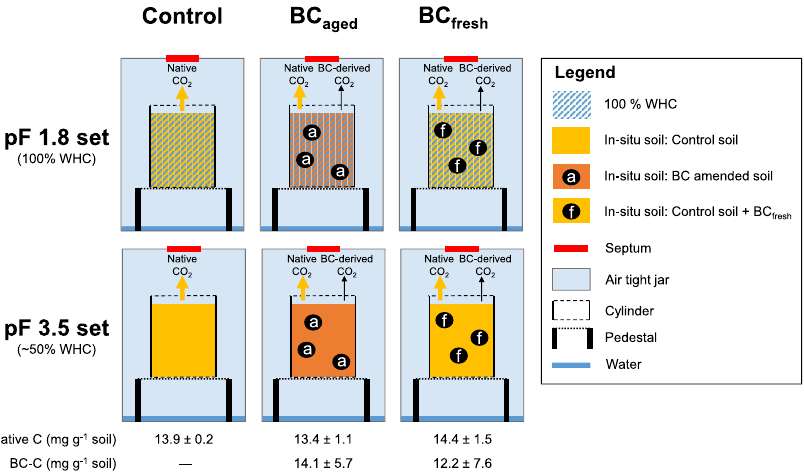
Figure 1. Experimental set-up: Each amendment and set had three replicates, analyzed at five time points (n = 30). Control soil was soil from the field experiment without BC addition. BC aged was disturbed BC amended soil of the field experiment 3 years after field exposure. BC fresh was control soil from the field experiment mixed with fresh